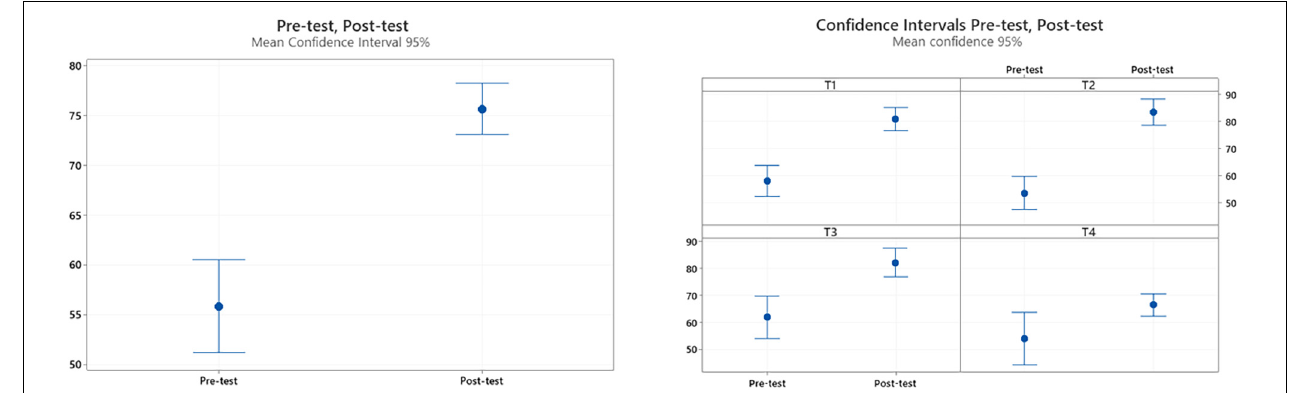
FIGURE 6 | Mean confidence intervals for the pre- and post-test. The entire sample and per teacher for the first activity.